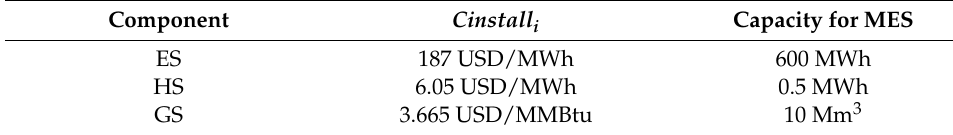
Table 4. The installation cost coefficient and capacity for storage devices.